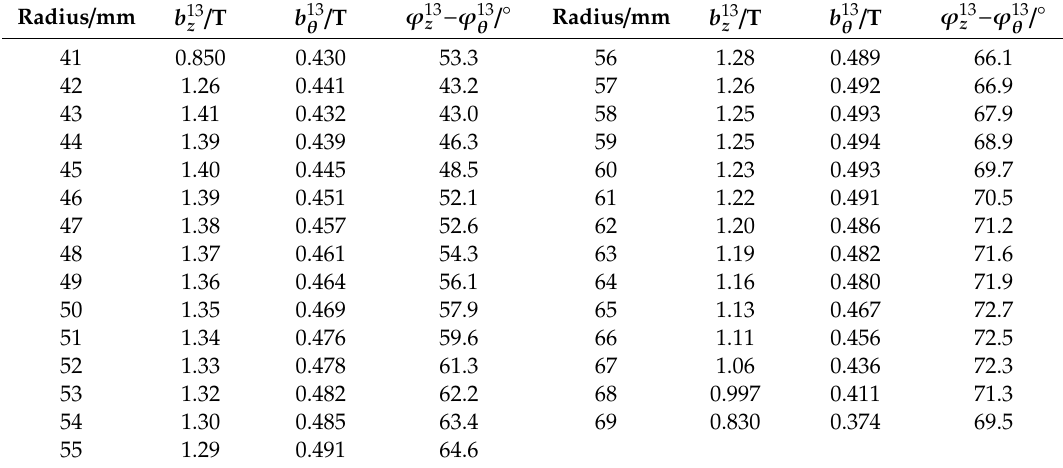
Table 2. Amplitudes and their phase di ff erences of the axial and tangential flux densities of 13th-order harmonics at di ff erent